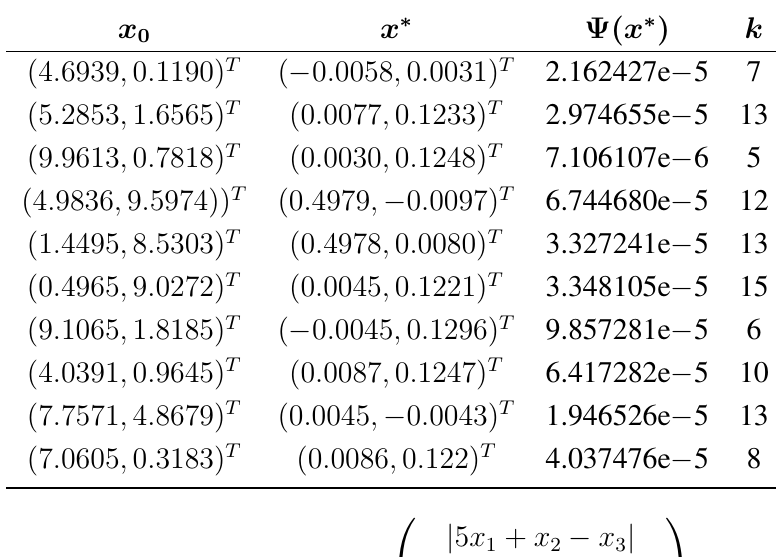
Table 2. Number of iterations and the final value of Ψ( x ∗ )